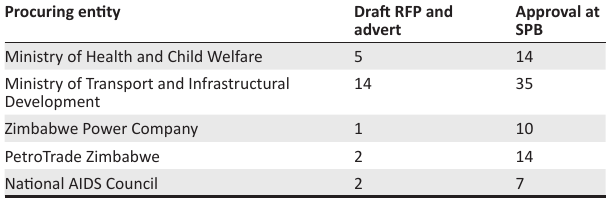
TABLE 6: Length of approval